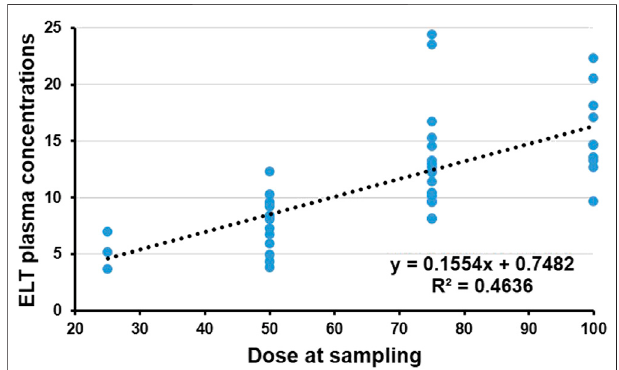
FIGURE 2 | Plasma concentration and dose of Eltrombopag (ELT). The regression equation of the relationship between the dose of ELT and concentration was successfully determined ( Y (cid:1) 0.7482 + 0.1554 X , p < 0.001). The plasma concentration of ELT was signi fi cantly positively correlated with the daily dose of ELT ( r 2 (cid:1) 0.4636, p <